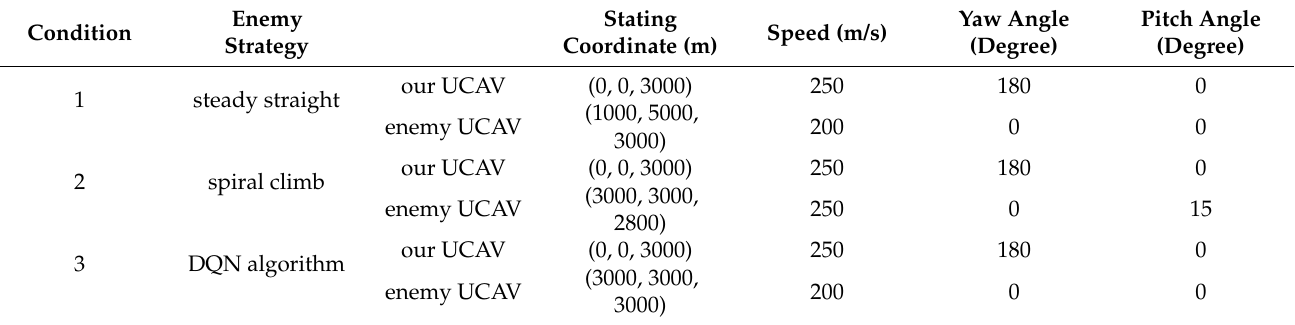
Table 2. The initial states of two UCAVs in three groups of experiments.